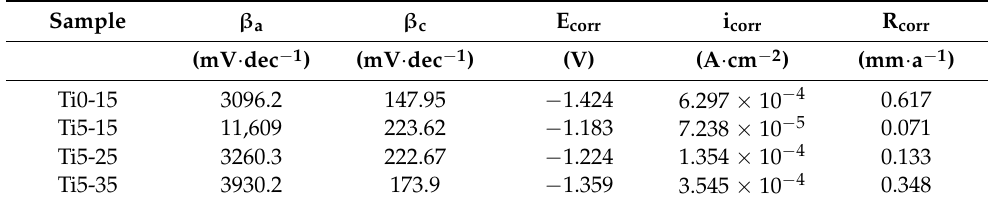
Figure 8 . Potentiodynamic polarization curves of coatings Ti0 ‐ 15, Ti5 ‐ 15, Ti5 ‐ 25 and Ti5 ‐ 35. Figure 8. Potentiodynamic polarization curves of coatings Ti0-15, Ti5-15, Ti5-25 and Ti5-35. Table 5. Fitting data obtained from the polarization curves of coatings Ti0-15, Ti5-15, Ti5-25 and